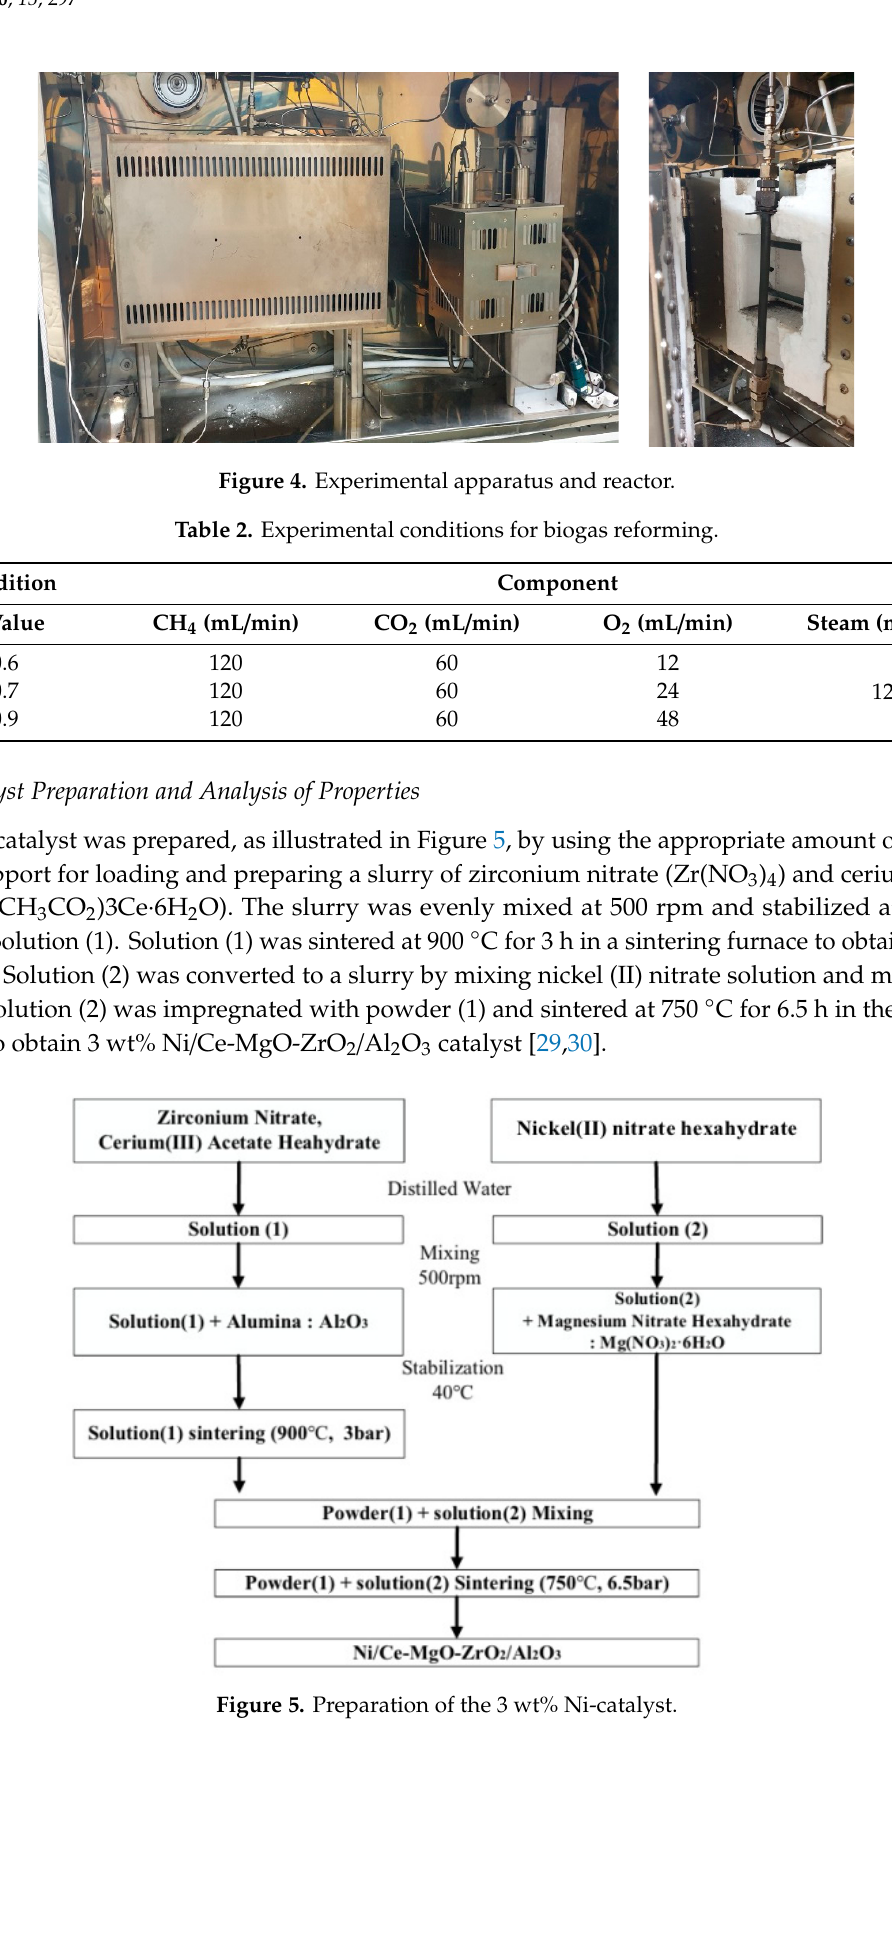
Figure 6. XRD patterns of the 3 wt% Ni/Ce-MgO-ZrO 2 /Al 2 O 3 catalyst: ( a ) before reforming and ( b ) after 200-h reforming. Table 4 summarizes the composition of the catalyst determined by ICP-OES. The contents of Ce and MgO in the catalyst decreased slightly, while those of NiO and Zr remained consistent after reforming. Figure 7 shows a scanning electron microscopy (SEM) image of the catalyst surface, which confirms that the catalyst has a relatively even particle size and shape [35].